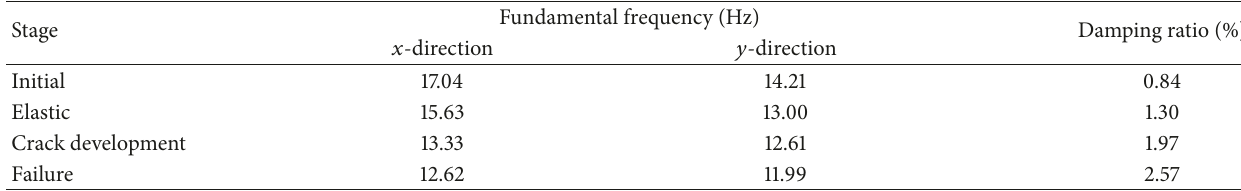
Table 5: Fundamental frequency and damping ratio of the